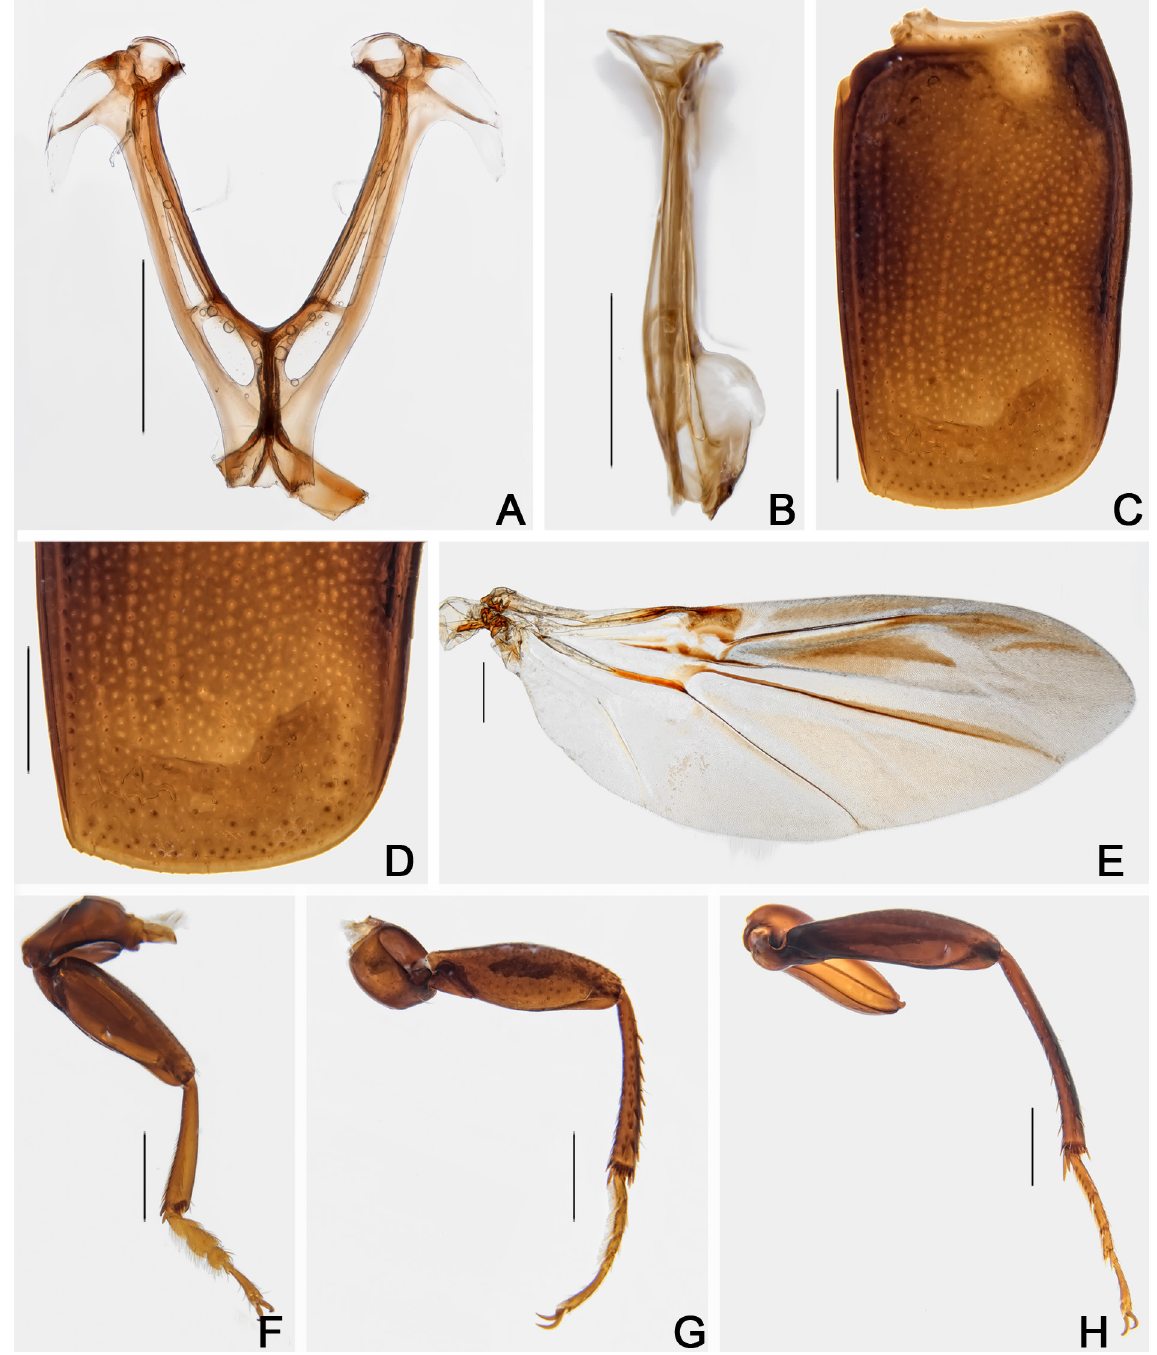
Fig. 42. Cyparium pici sp. nov., paratype, ♂ (CELC). A–B . Metendosternite. A . Dorsal view. B . Lateral view. C–D . Elytron. C . Entire. D . Apex. E . Hind wing. F–H . Legs. F . Fore. G . Middle. H . Hind. Specimen collected at Cotriguaçu (MT, Brazil). Scale bars = 0.5